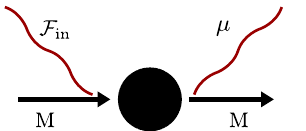
Fig. 1 Absorption of a wave with energy profile F in by a black hole of mass M and possible subsequent evaporation in the classical, semi-classical and fully quantum treatment